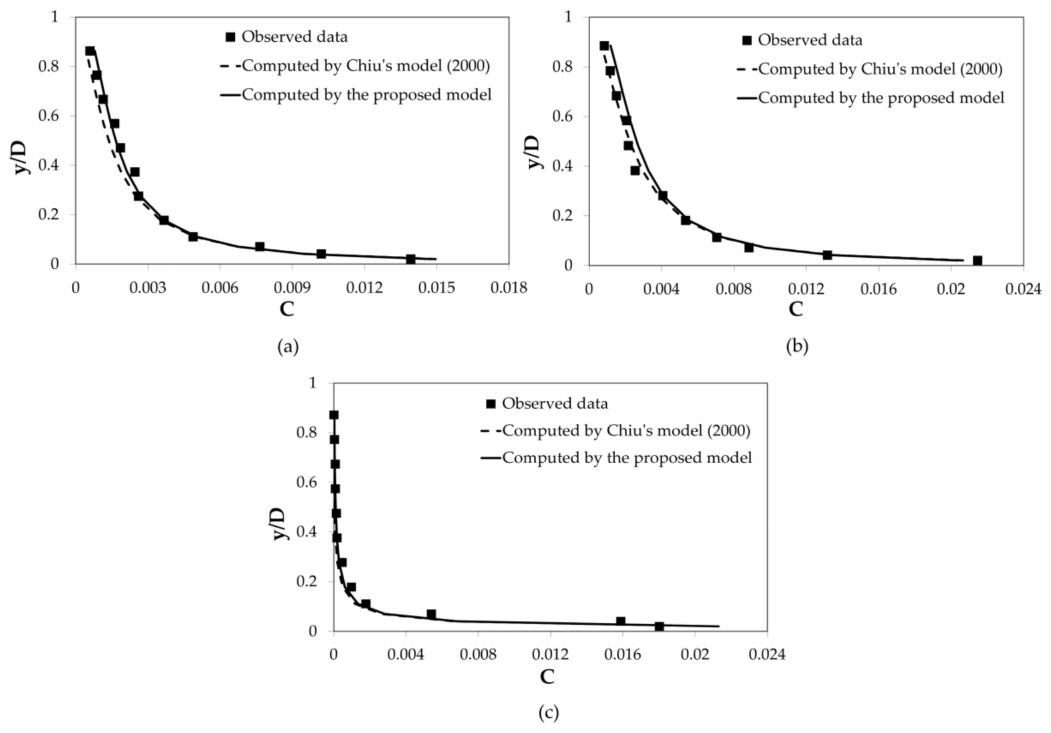
Figure 1. Comparison between the theoretical concentration profiles and Valiani’s data: